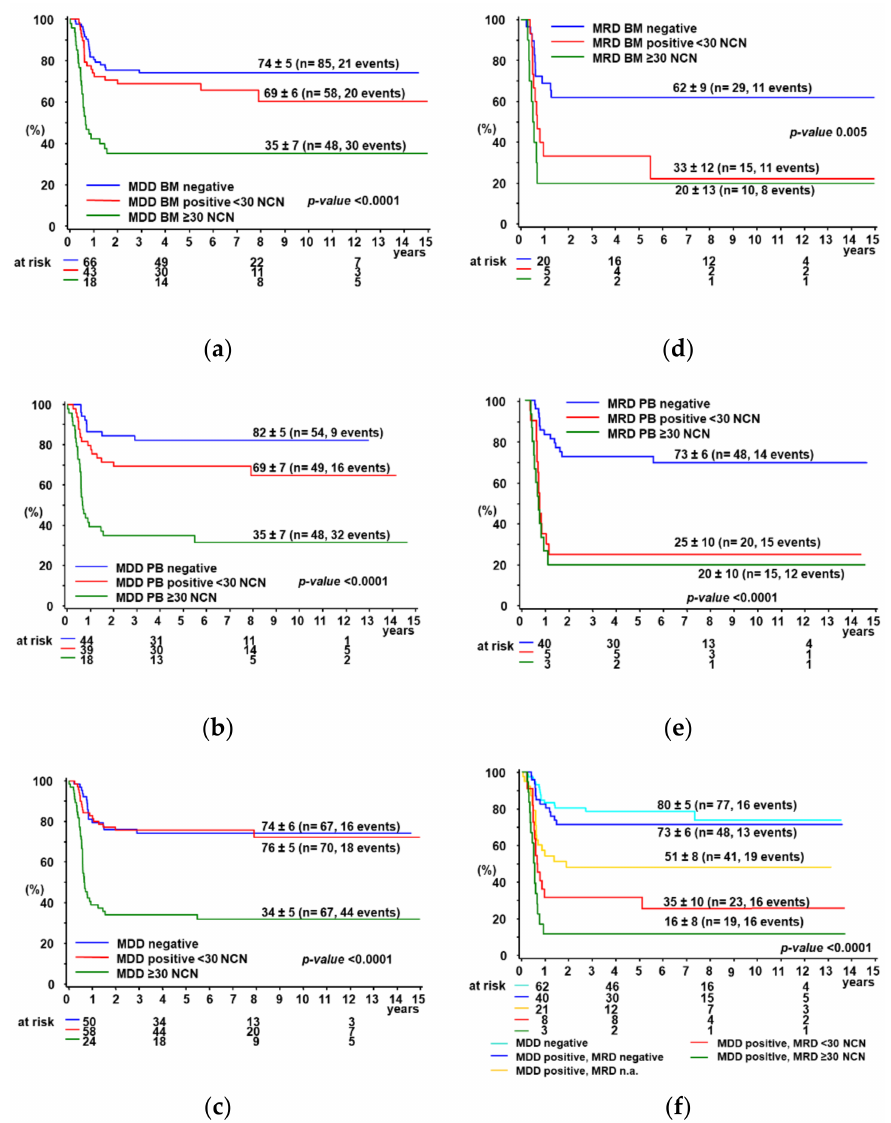
Figure 2. 5-year PFS% according to MDD (negative, positive < 30 NCN or ≥ 30 NCN) in BM ( a ), PB ( b ), combined ( c ) and according to MRD (negative, positive < 30 NCN or ≥ 30 NCN) in BM ( d ), PB ( e ) and combined ( f ). Definition for combined groups ( c , f ): MDD/MRD negative: both BM and PB were negative or one of them if only one was available; MDD/MRD positive: the highest measured NCN was chosen between BM and PB determinations or one of them, if only one was